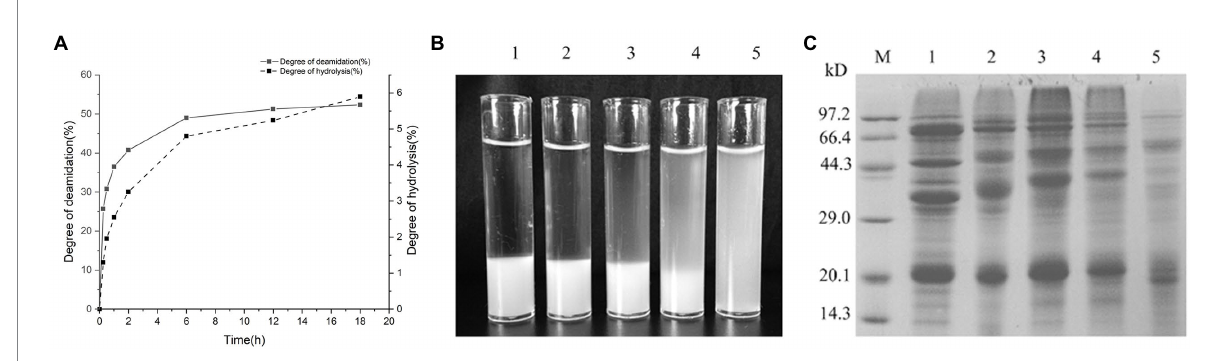
FIGURE 8 Changes in DD and DH of soy protein isolate (SPI) as a function of reaction time (A) ; appearance of 1% deamidated SPI with PG for 0, 0.5, 2, 6, and 18 h in phosphate buffer (200 mM, pH 7.0), respectively (B) , and SDS-PAGE of SPI deamidated with PG for 0, 0.5, 2, 6, and 18 h, respectively (C)